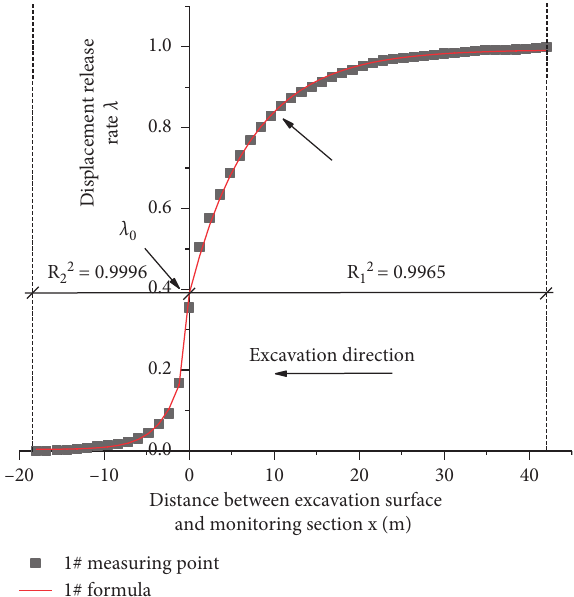
Figure 21: 1# comparison chart of measuring points and fitting function